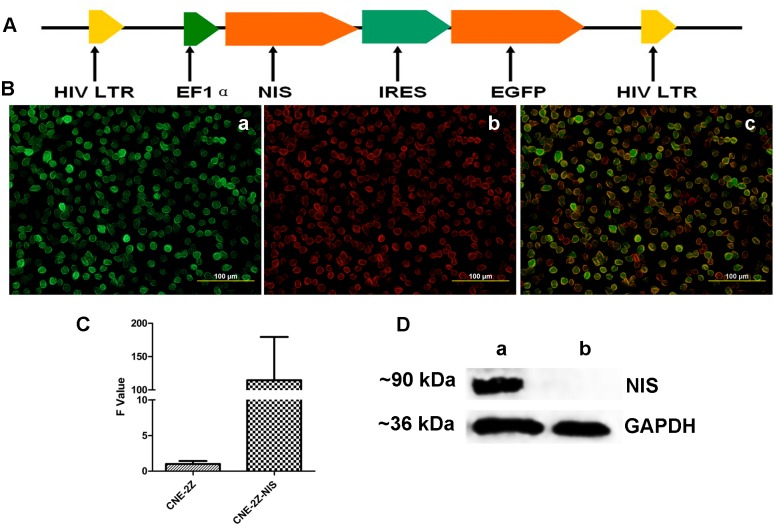
Construction and expression of a two-gene vector containing NIS and EGFP.(A) Schematic representation of the functional NIS gene and EGFP (green fluorescent protein reporter) gene in Lv-EF1α-NIS-IRES-EGFP. (B) Immunofluorescence showing that NIS and EGFP were strongly expressed in the CNE-2Z-NIS cells. (a: green color shows EGFP expression; b: red color shows NIS expression; c: a merged picture) (magnification, 400×). (C) qPCR analysis of NIS expression in CNE-2Z and CNE-2Z-NIS cells. NIS mRNA expression normalized to the GAPDH endogenous reference was detected by qRT-PCR. Results are expressed as means ± SD of three independent experiments. (D) Western blot analysis of NIS expression in CNE-2Z and CNE-2Z-NIS cells. NIS protein (~90 kDa) expression in CNE-2Z-NIS but not in CNE-2Z cells was analyzed by Western blot. GAPDH (~36 kDa) was used as an internal control (a: CNE-2Z-NIS; b: CNE-2Z). All experiments were performed in triplicate.